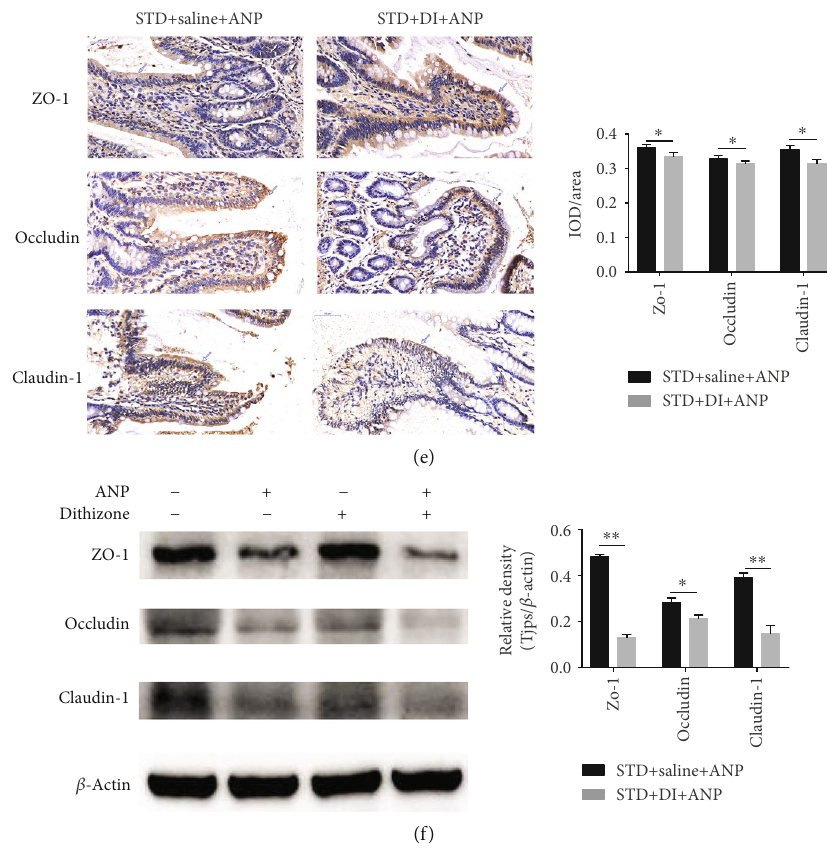
Figure 4: E ff ects of dithizone on pancreatic and intestinal injuries in rats on standard diet followed by retrograde sodium taurocholate infusion. (a) Pancreas and distal ileum sections of rats treated with dithizone or saline. Tissue was stained with H&E (magni fi cation × 200). (b) Histopathological scores of the pancreas and distal ileum. (c) Serum TNF α , IL-1 β , supplementary, and IL-17A levels in rats treated with dithizone or saline. (d) DAO activity and serum D-lactate in rats treated with dithizone or saline. (e) Distal ileum sections showing immunostaining for claudin-1, occludin, and zo-1, together with quanti fi cation of claudin-1, occludin, and zo-1 staining. (f) Expression of claudin-1, occludin, and zo-1 as assessed by western blot. ∗ p < 0 : 05 , ∗∗ p < 0 : 01 , ∗∗∗ p < 0 : 001 , Student ’ s t -test. Results were expressed as the mean ± SD ( n = 5